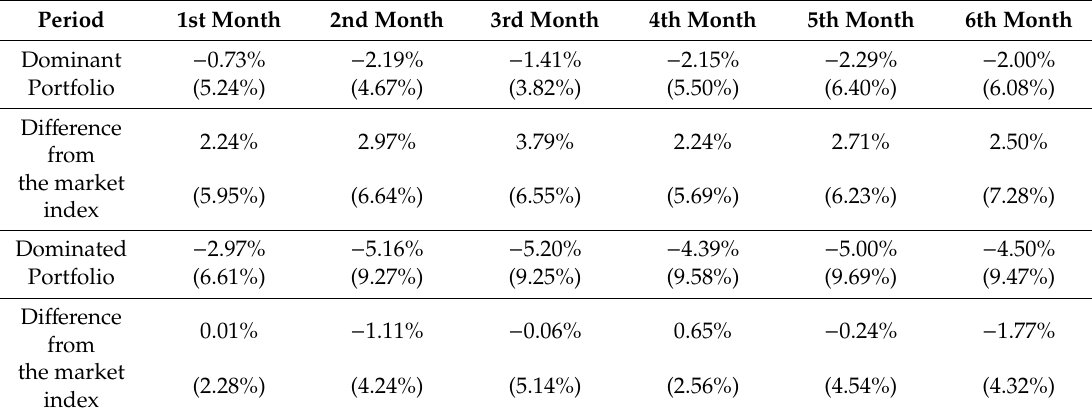
Table 6. Bearish period (2007: 8–2008: 8) returns after